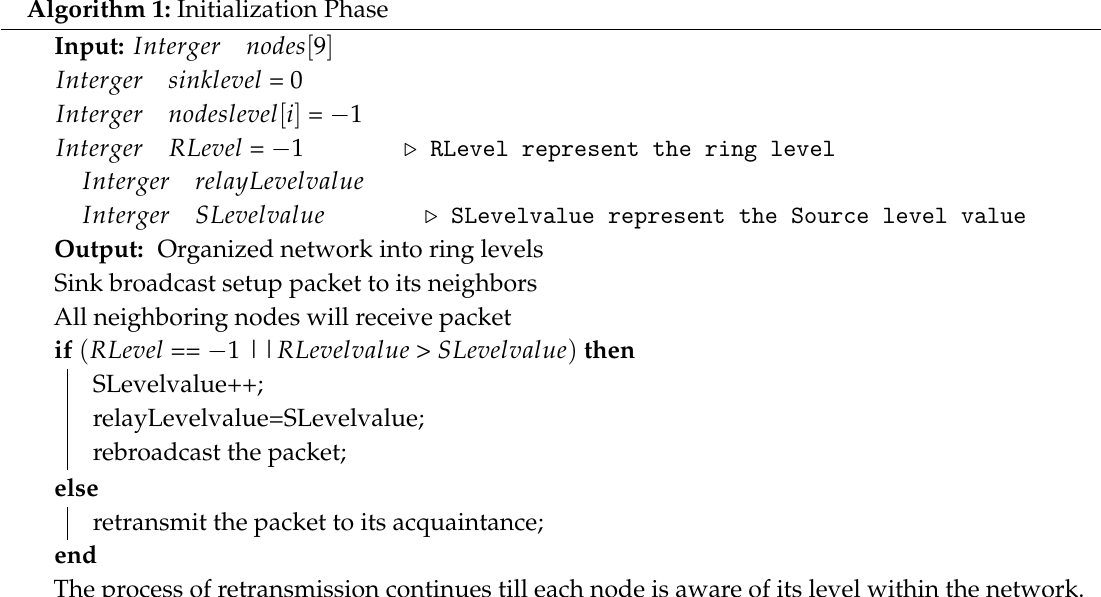
Algorithm 1: Initialization